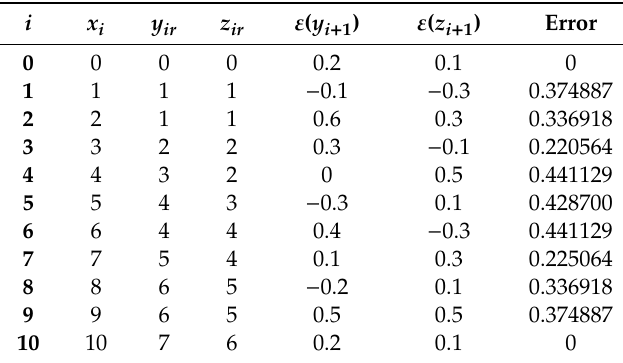
Table 1. Line generation based on Liu’s